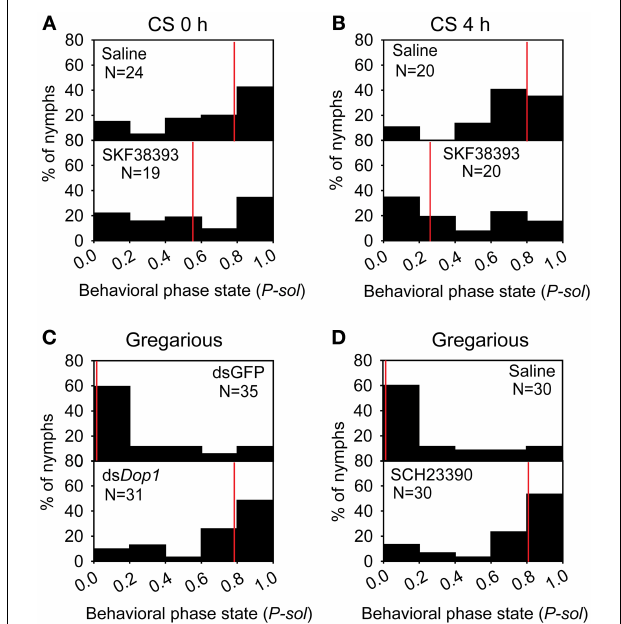
FIGURE 4 | Locusta Dop1 promotes the gregariousness of solitary locusts. (A) The behavioral phase state of solitary locusts after injection of Dop1 agonist, SKF38393. (B) The behavioral phase state of crowded solitary locusts after injection of Dop1 agonist, SKF38393. (C) The behavioral phase state of gregarious locusts after RNAi knockdown of Locusta Dop1 . (D) The behavioral phase state of gregarious locusts after injection of Dop1 antagonist, SCH23390. The behavioral comparison between controls and the treatments were analyzed by Mann–Whitney U -test ( P < 0 . 05 ). Red lines indicate the medians of P-sol values. P-sol , probabilistic metric of solitariness. Abbreviations: CS, crowding of solitary locusts.